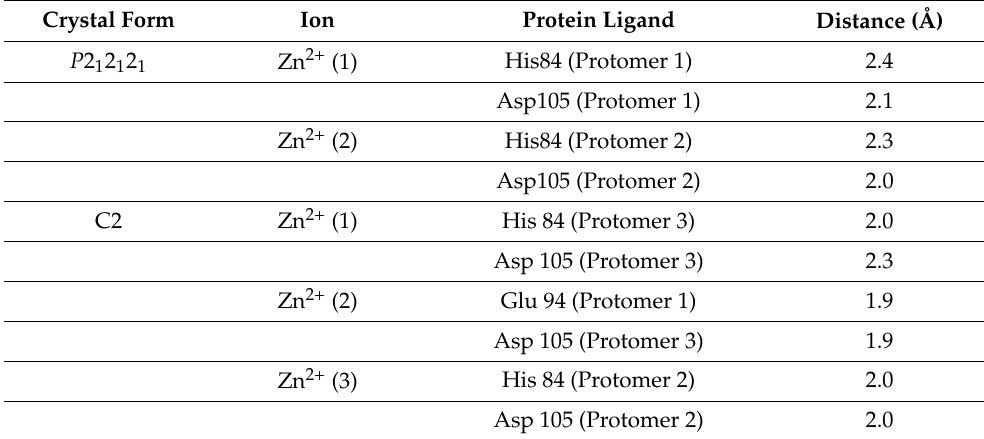
Table 2. Description of the characteristics of the space groups of NGF-Zn 2+ structures. Crystal